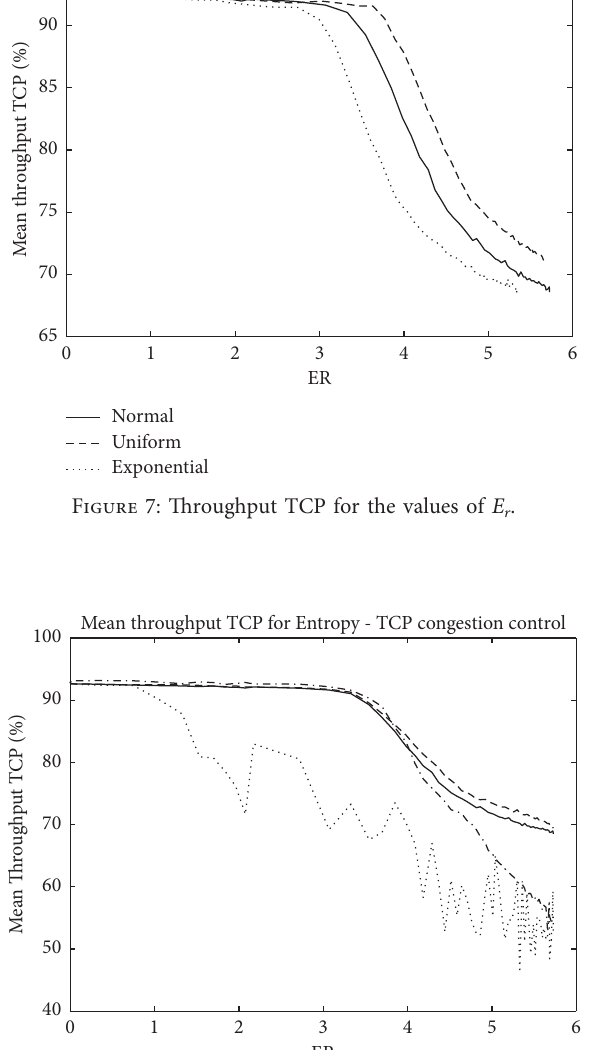
Figure 8: TCP throughput using different congestion controls for E r